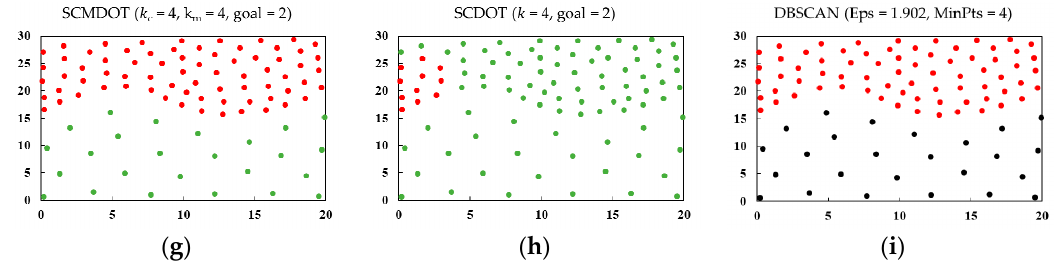
Figure 6. Illustration of clustering results in Experiment 2. ( a – c ) The clustering results of DS4; ( d – f )